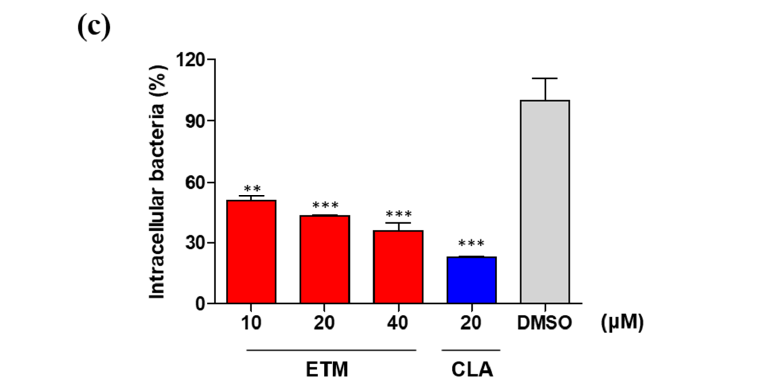
Figure 4. Etamycin intracellular activity in mWasabi protein-expressing M. abscessus -infected mBMDMs. ( a ) Images of mWasabi protein-expressing M. abscessus subsp. abscessus CIP104536 T (S) infected mBMDMs cells on day 3 after treatment with di ff erent concentrations of etamycin (10, 20, and 40 µ M). DMSO and clarithromycin at 20 µ M were used as negative and positive controls, respectively. After 3 days, cells were stained with syto60 (red), and the cells were analyzed using the automated cell imaging system. The yellow colors indicated mWasabi protein-expressing M. abscessus that were phagocytized by red-stained mBMDMs. ( b ) The cell number of M. abscessus -infected mBMDMs was enumerated after treatment with each compound. ( c ) Pixel intensities of mWasabi-expressing M. abscessus in mBMDMs were quantified after treatment of cells with di ff erent concentrations of etamycin and were compared with those of negative (DMSO) and positive (clarithromycin; 20 µ M) controls. The relative di ff erence (** p < 0.01; *** p < 0.001) was compared with the DMSO control. Data are expressed as the mean ± SD of duplicates for each concentration. CLA: Clarithromycin and ETM: Etamycin. Scale bar: 55.2 µ